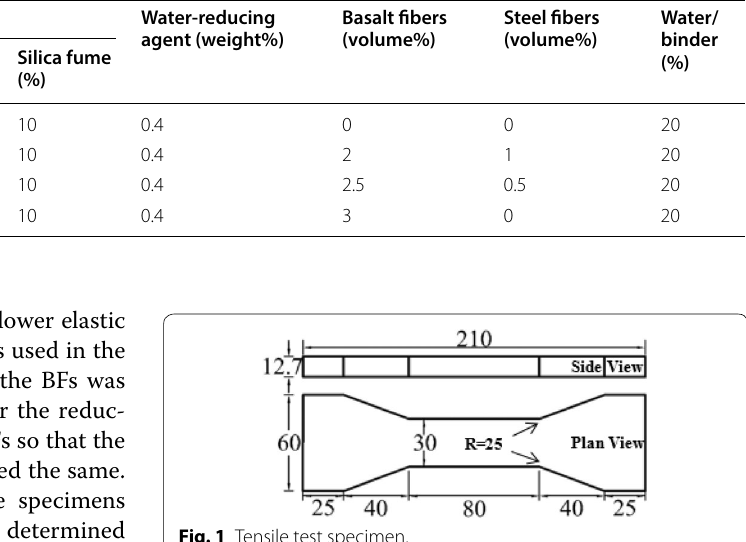
Table 3 Mixture compositions of SHCC specimens.